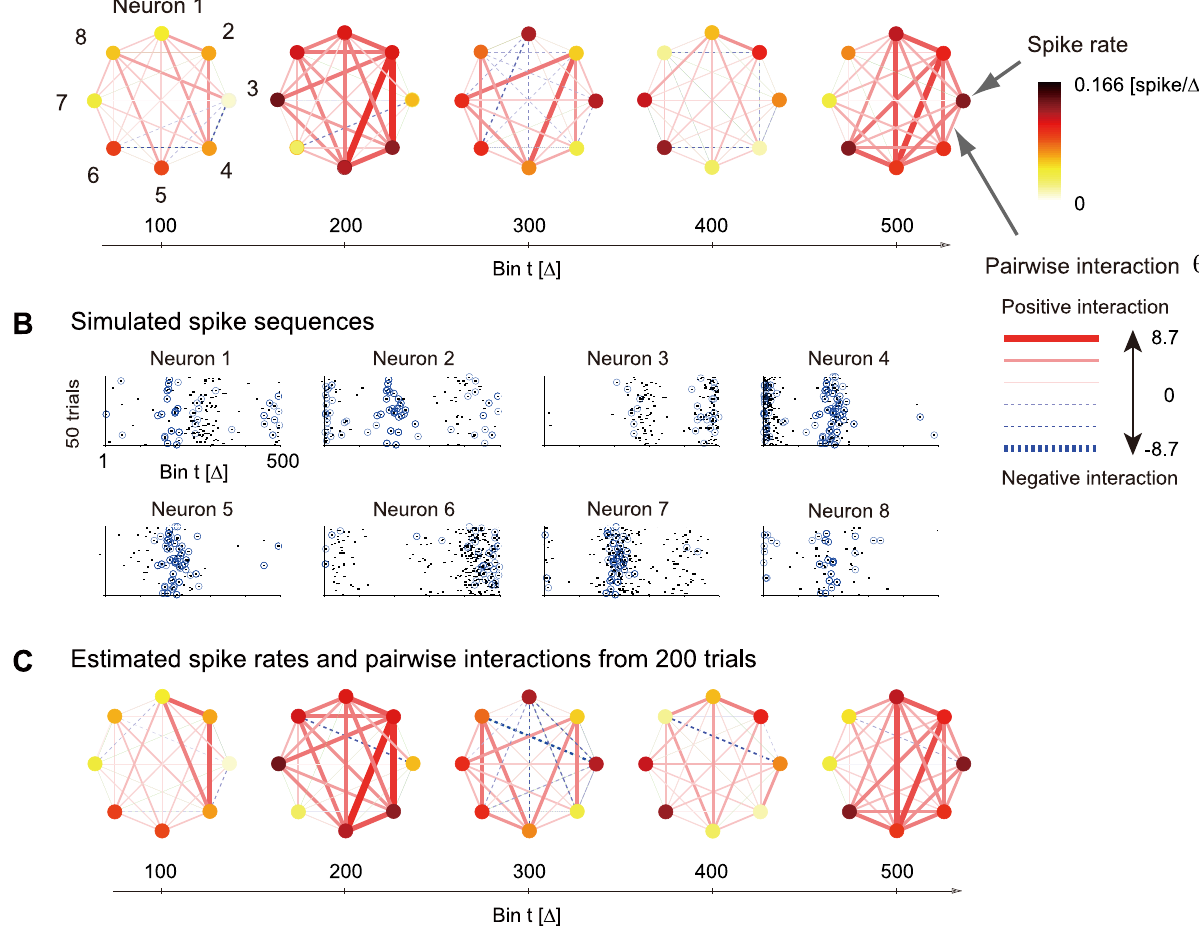
Figure 3. Simultaneous estimation of pairwise interactions of 8 simulated neurons. (A) Snapshots of the underlying model parameters of a time-dependent log-linear model of N ~ 8 neurons containing up to pairwise interactions (duration: T ~ 500 bins) at t ~ 100,200,300,400 and 500th bins. No higher-order interactions are included in the model. Each node represents a single neuron. The strength of a pairwise interaction between ( i , j ~ 1, ... ,8 ), is expressed by the color as well as the thickness of the link between the neurons (see legend at the right of the i th and j th neurons, h t ij panel B). A red solid line indicates a positive pairwise interaction, whereas a blue dashed line represents a negative pairwise interaction. The ( i ~ 1, ... ,8 ), are coded by the color of the nodes (see color bar to the right of panel A). (B) Dot underlying spike rates of the individual neurons, g t i displays of the simulated parallel spike sequences of 8 neurons, X t , l , sampled repeatedly for n ~ 200 trials from the time-dependent log-linear model shown in A. For better visibility, only the first 50 trials are displayed ( l ~ 1, ... ,50 ). Synchronous spike events between any two neurons (28 pairs in total) are marked by blue circles. (C) Pairwise analysis of the data illustrated in B (using all n ~ 200 trials) assuming a pairwise model ( r ~ 2 ) of 8 neurons. The snapshots at the t ~ 100,200,300,400 and 500th bins show smoothed estimates of the time-varying pairwise interactions, h t ( I [ V 1 ). For this estimation, we use S ~ 10 { 4 I for the prior density of initial parameters. The scales are identical to the one in panel the spike rates, g t I